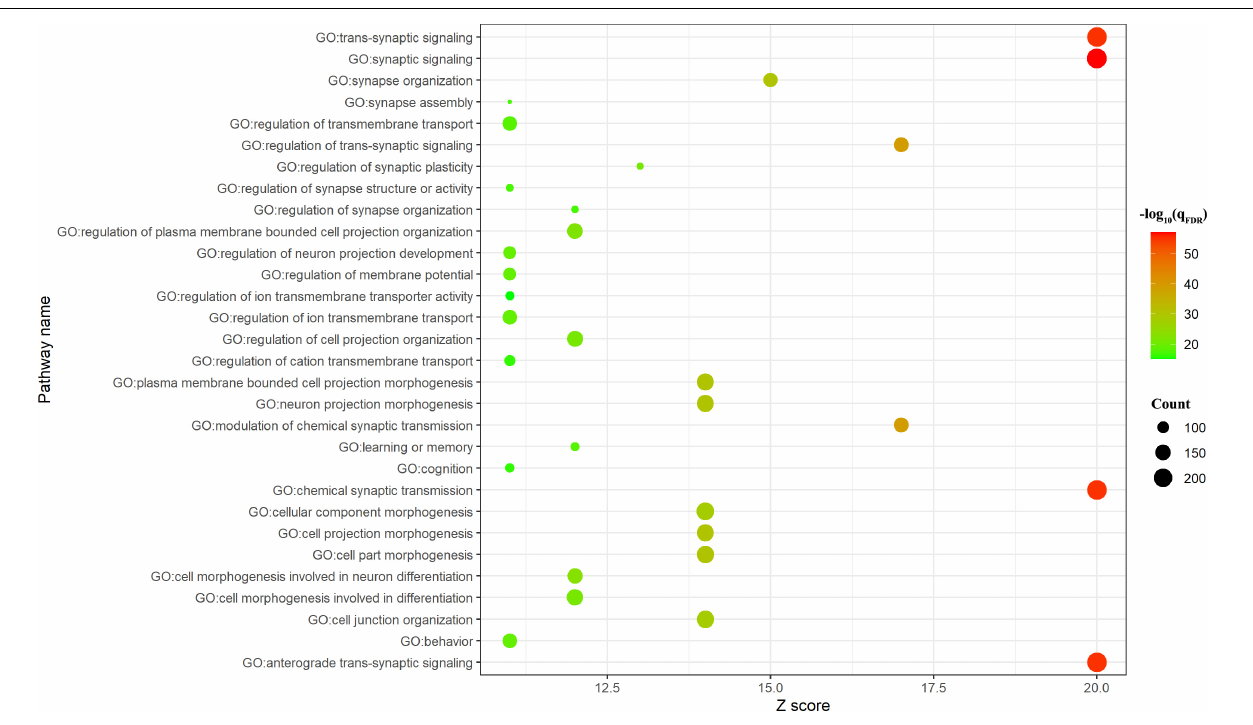
FIGURE 2 | Top 20 significant Gene Ontology (GO) biological processes/Kyoto Encyclopedia of Genes and Genomes (KEGG) pathways. The count meant the number of genes involved in the given